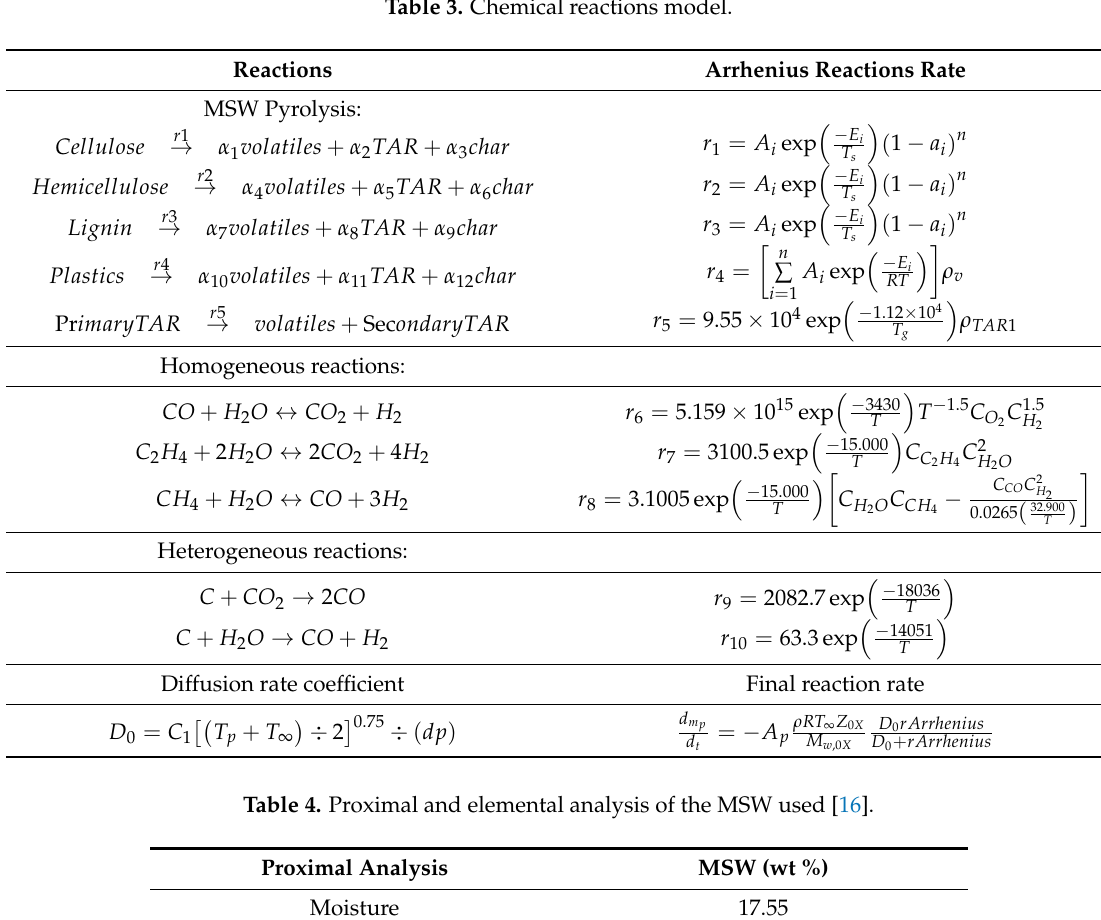
Table 3. Chemical reactions model.